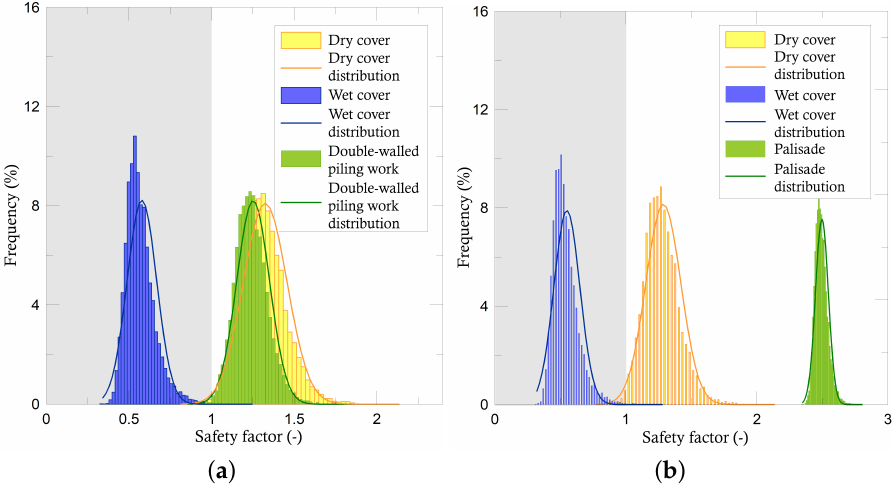
Figure 16. Distributions of F s obtained from the probabilistic analysis for the slopes S1 ( a ) and S2 ( b ).